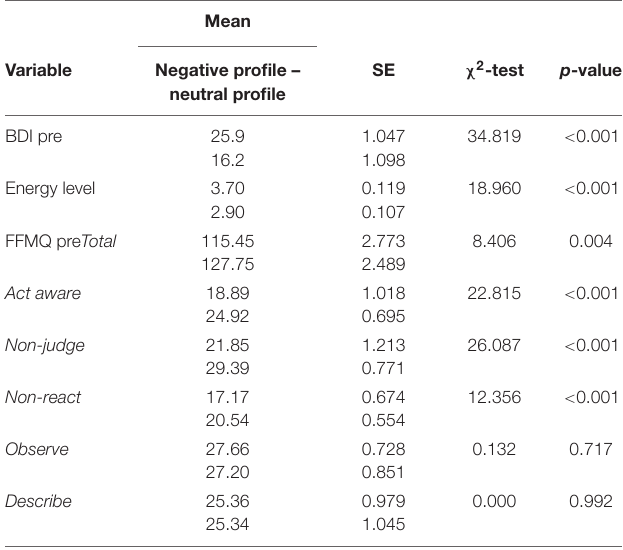
TABLE 4 | The statistical 3-step method analysis of the relationships of the LPA profiles with the outcome